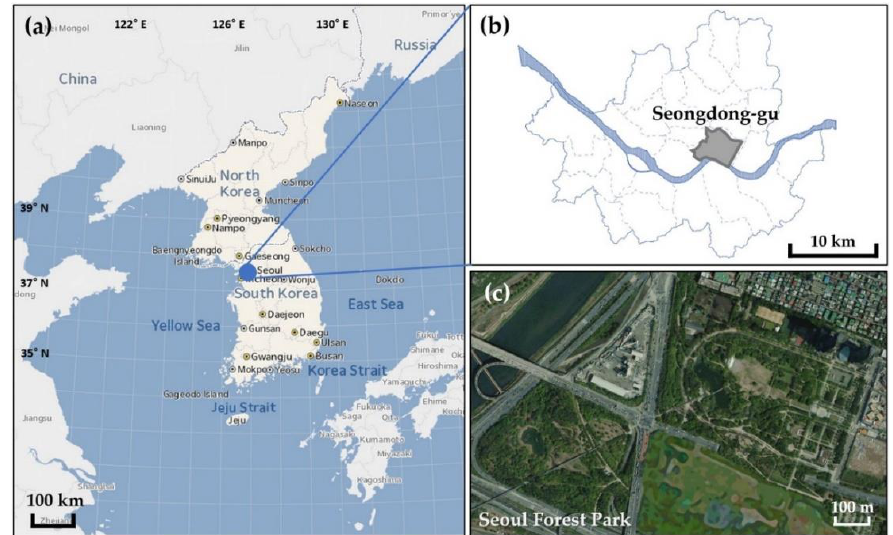
Figure 1. Schematic diagram of a sampling site in Seoul, South Korea (National Geographic Information Institute): ( a ) Korea; ( b ) Seoul sampling site; and ( c ) Seoul Forest Park (digital map image).